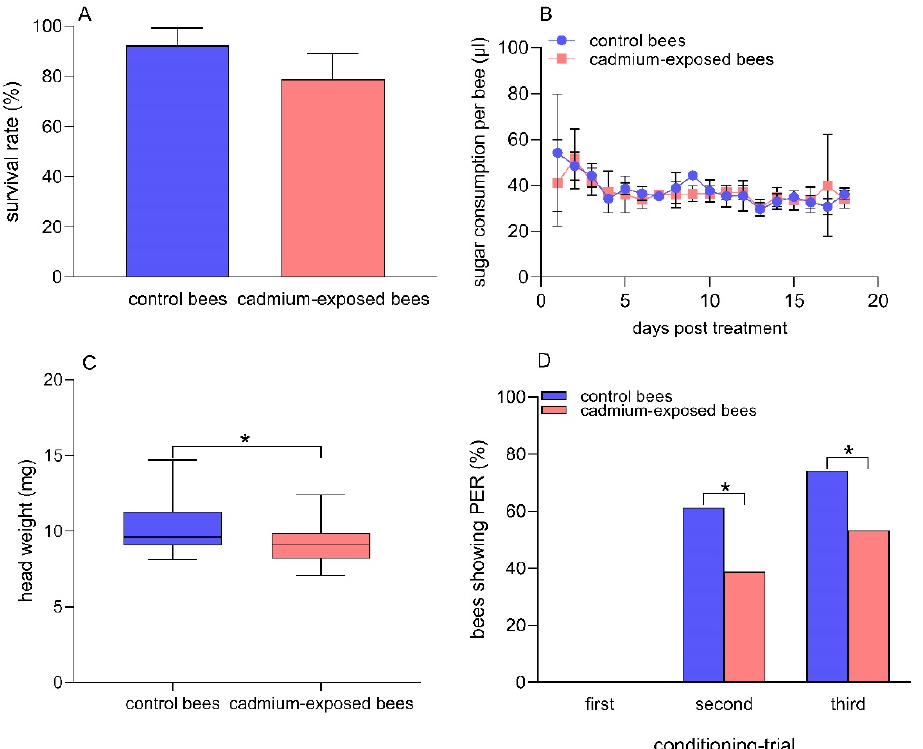
Figure 1. Comparison between cadmium-exposed and control bees in survival rate ( A ) sugar con- summation per bee; ( B ) head weight; ( C ) Student’s t-test, n = 21 in both groups of bees, and the percentage of bees showing PER when presented with the CS +, 1-nonanol; ( D ) Fisher’s exact test, n = 70 for control bees, n = 62 for cadmium-exposed bees after chronic Cd exposure. (*) p < 0.05.